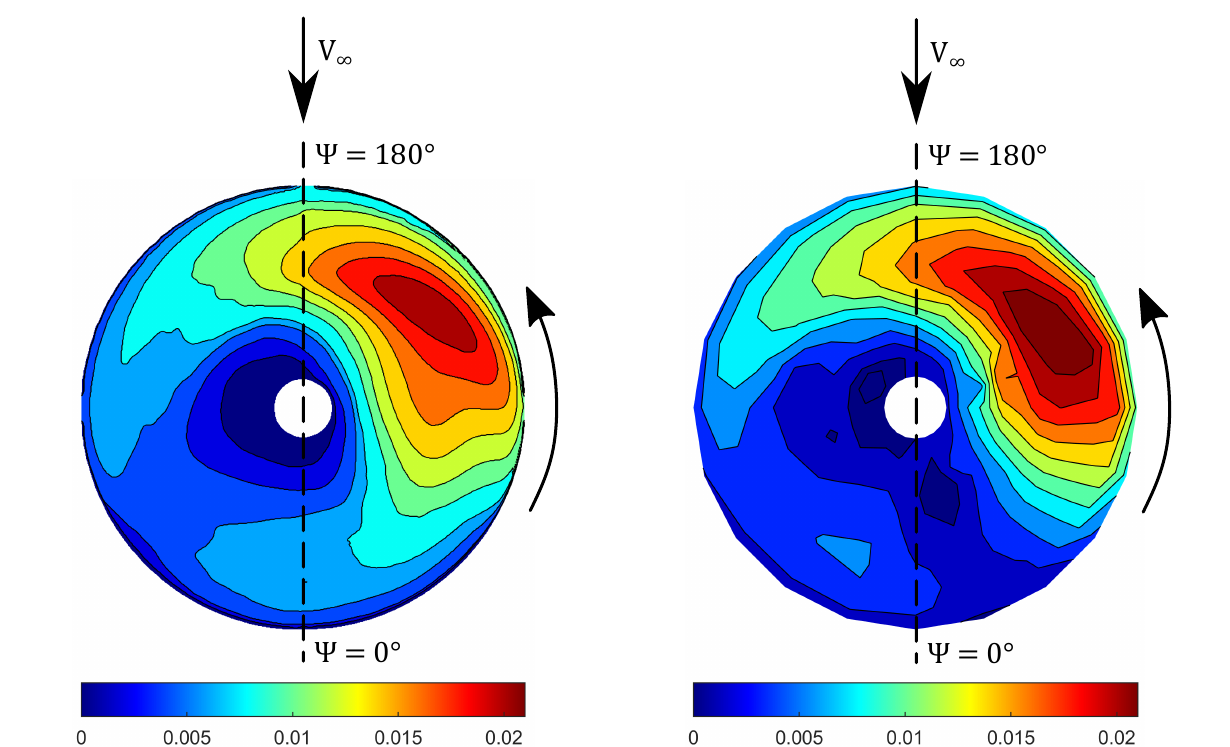
Figure 10. Sectional thrust coefficient d C T /d ( r / R ) predictions for α tpp = 5 ◦ , µ = 0.162. ( a ) CFD predictions [5]. ( b ) DDE metond predictions.